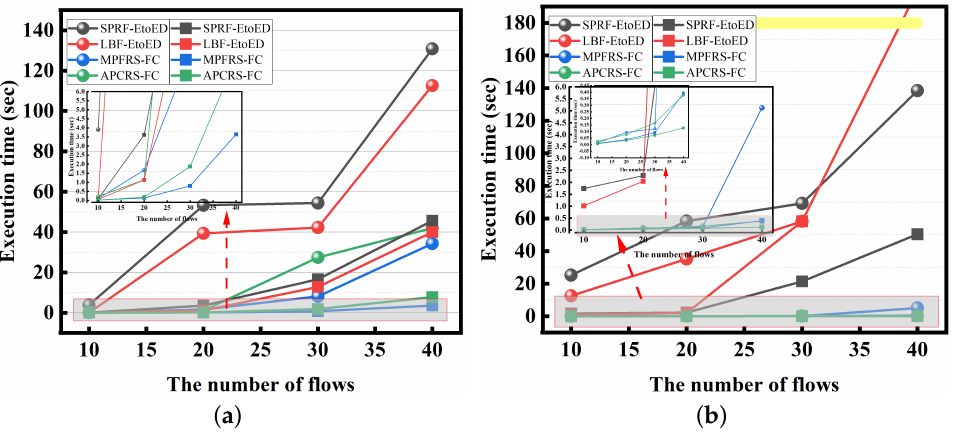
Figure 8. Maximum execution time and average execution time for the SPRF-EtoED, LBF-EtoED, MPFRS-FC, and APCRS-FC for 100 synthetic test cases with different number of flows, tested in MM network. ( a ) Flows chosen from flow group 1. ( b ) Flows chosen from flow group 2.